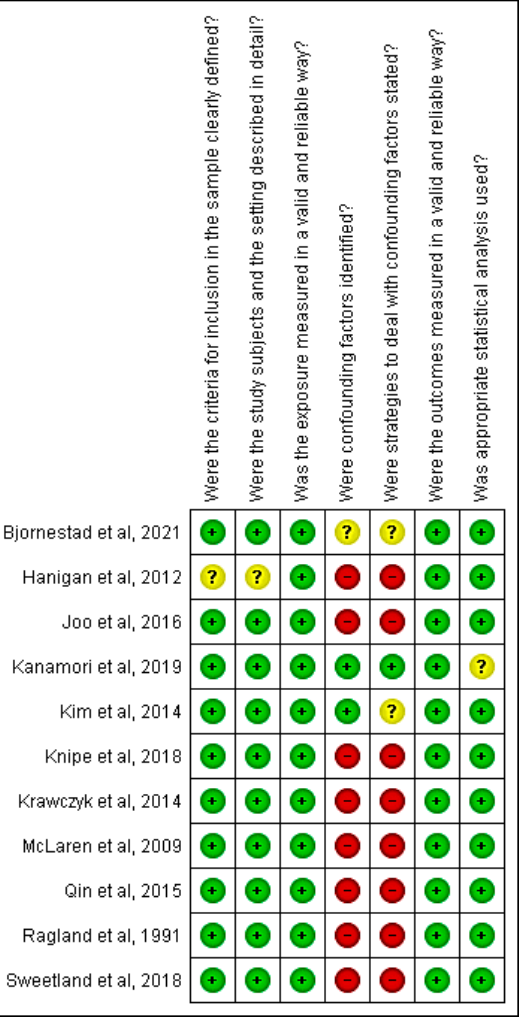
Figure 2. Bias risk for cross-sectional studies included in the review.